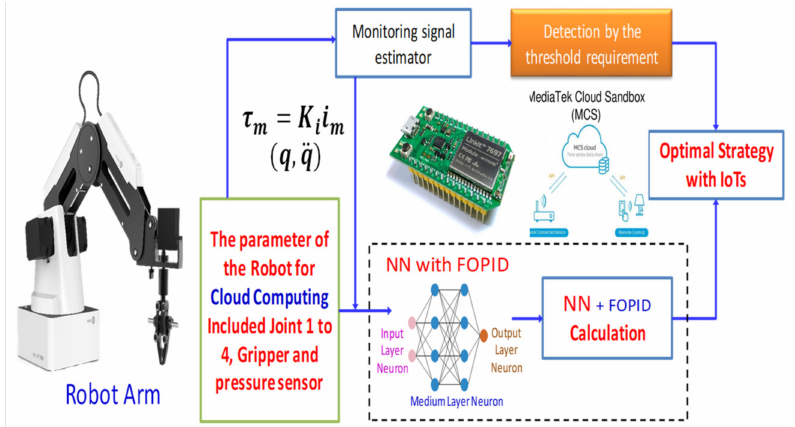
Figure 10. Neural network regulated the fractional order PID controller to feedback the signal of the motor torque, and transmit the upload of each join datum to the IoT.